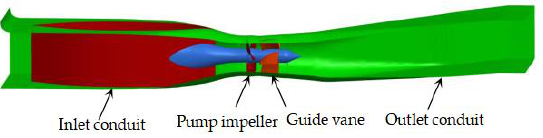
Figure 1. Perspective drawing of the shaft tubular pump device.